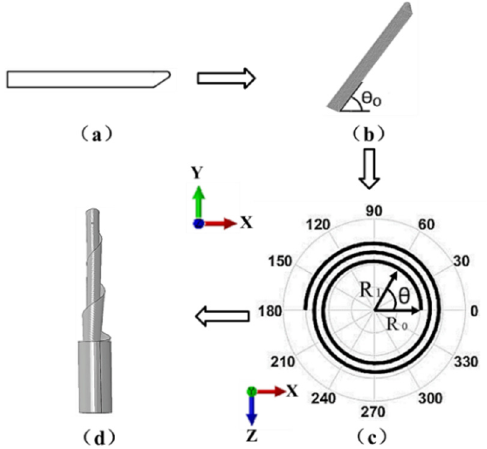
Figure 3. Geometric model of STACER ( a ) strip; ( b ) coordinates; ( c ) top view after curling and ( d ) spring reel.